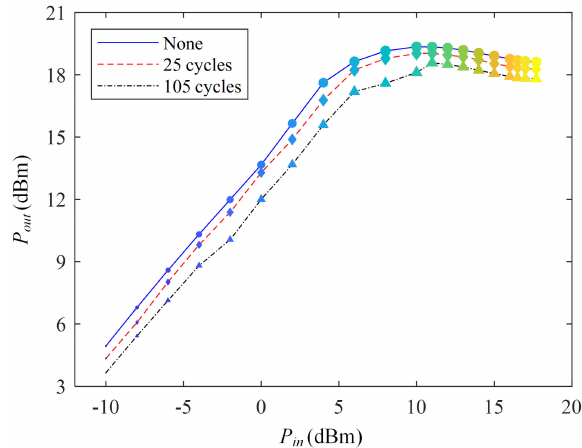
Figure 5. The output power of PA under thermal shock